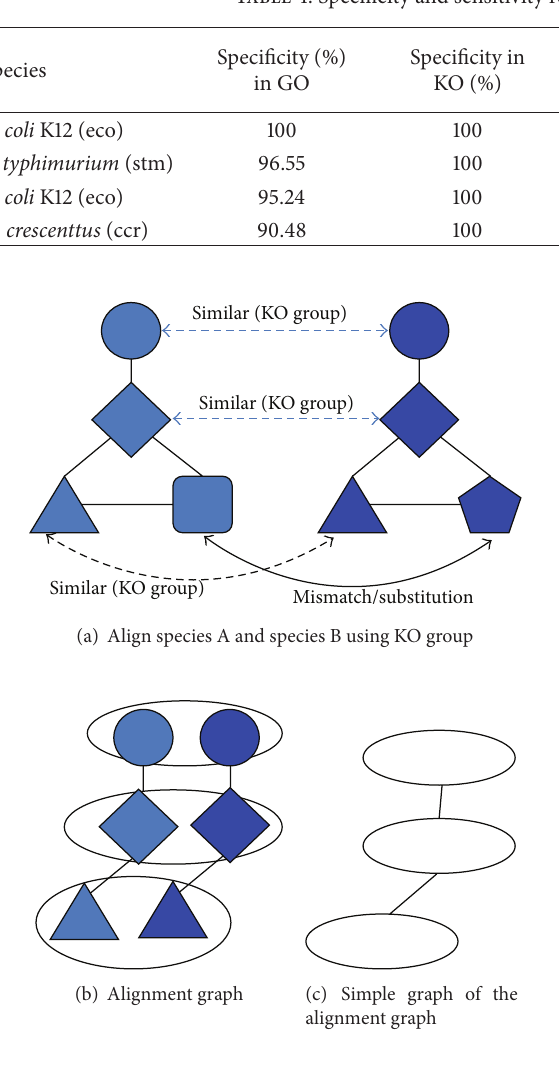
Figure 3: Building an alignment graph.